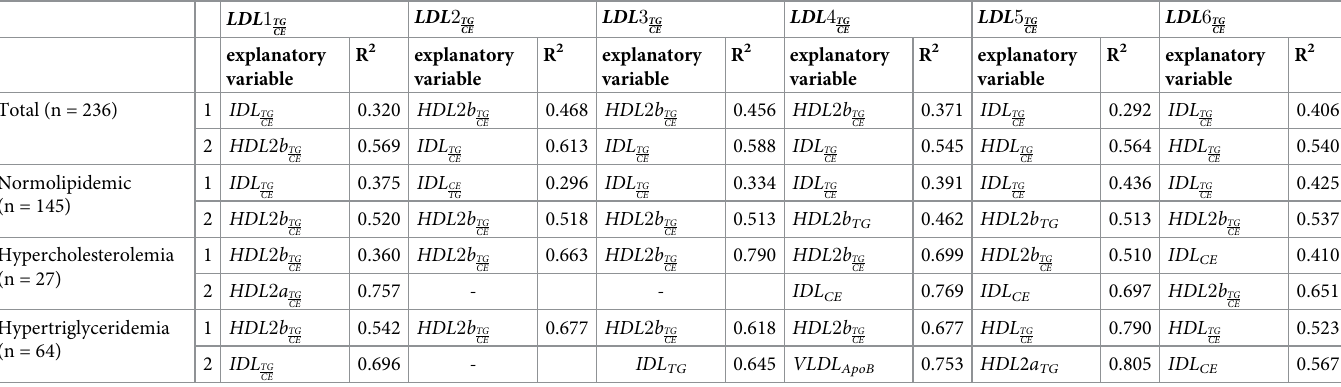
Table 2. Linear multiple regression on lipid composition in LDL’s